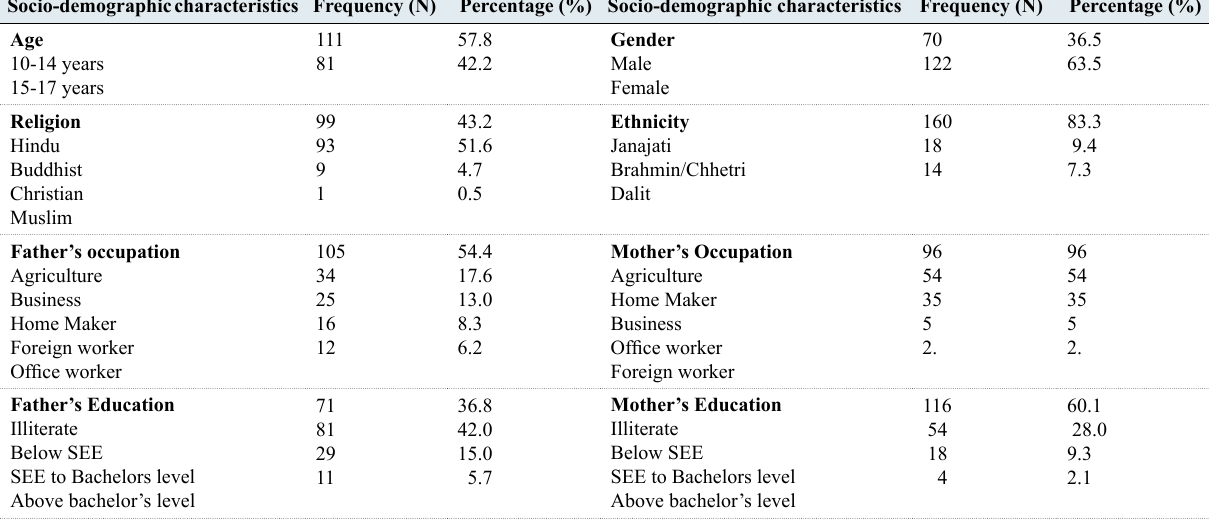
Figure 1: BMI category of adolescent school going children (n=192) Out of total 192 children, 125 ( 65.1%) were in normal category of BMI, followed by 53 (27.1%) in underweight (fig.1). Table 2 showed that proportion of students with underweight an overweight problem are more among age group 10-14 compared to age group 15-17. This is statistically significant with P value (0.00). Median Height for Age was 94.31(±6.5) with minimum 76.45 and maximum 111.86. Normal height was seen in 93 (48.4%) children and 99 (51.6%) children were stunted